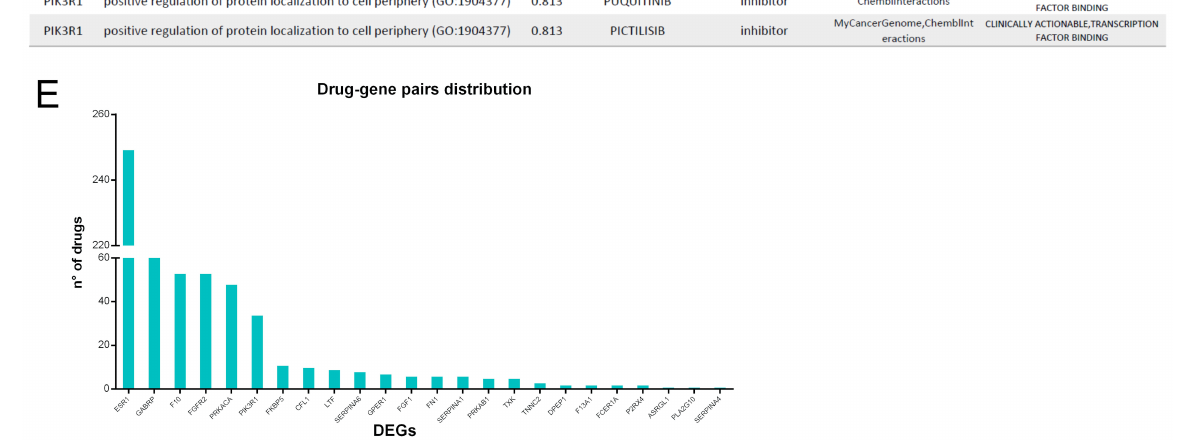
Figure 3. Drug repurposing: ( A – C ) Drugs identified through cMap querying, classified by CS, PCL, and FDA status. ( D ) Example of the dataset containing the list and all information relative to compounds identified through DGIdb querying. ( E ) Representation of the number of specific drugs found for each DEG in the